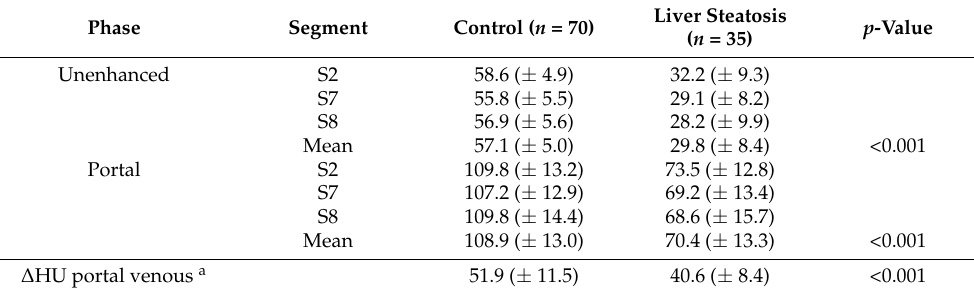
Table 2. Comparison of attenuation during unenhanced and portal phase in segments 2, 7, and